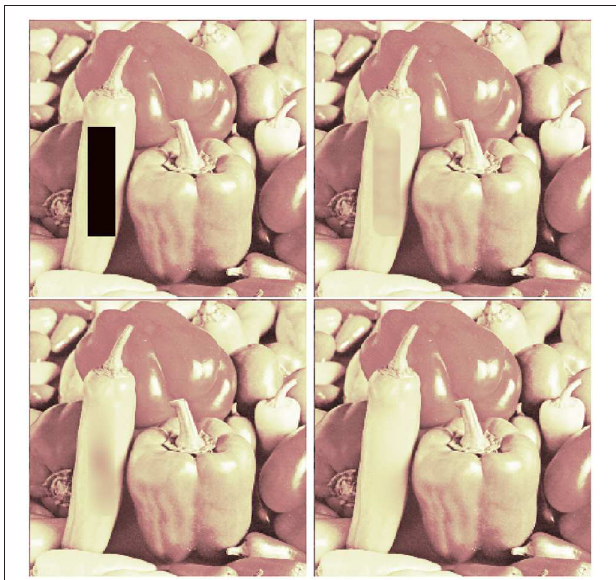
FIGURE 10 | Hole filling (smooth area): damaged image (top, left), reconstruction using standard TV inpainting (top, right) and reconstruction using spline inpainting of order 3 with TV norm (bottom, left), and squared TV norm (bottom, right).